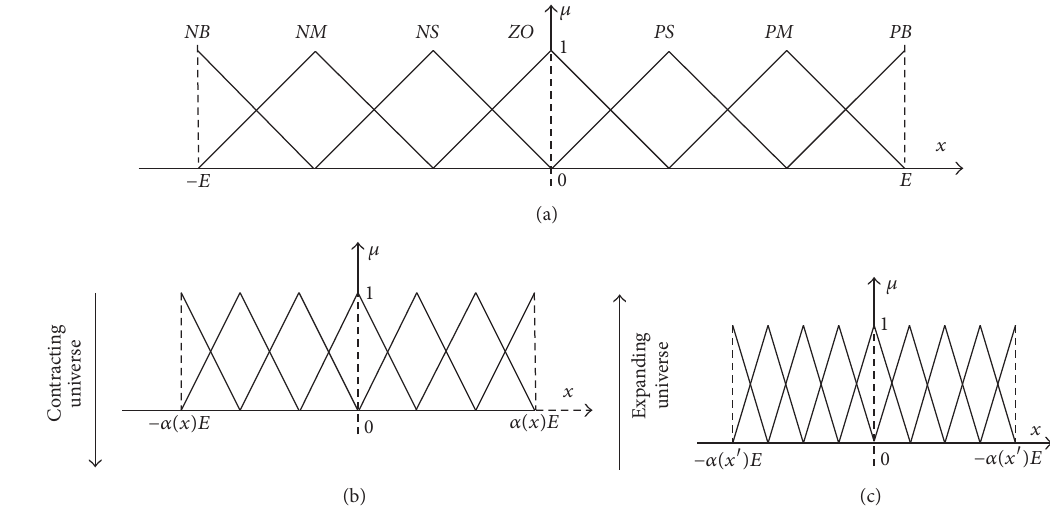
Figure 5: (a) The initial universe of its partition; (b) and (c) contracting-expending universes.